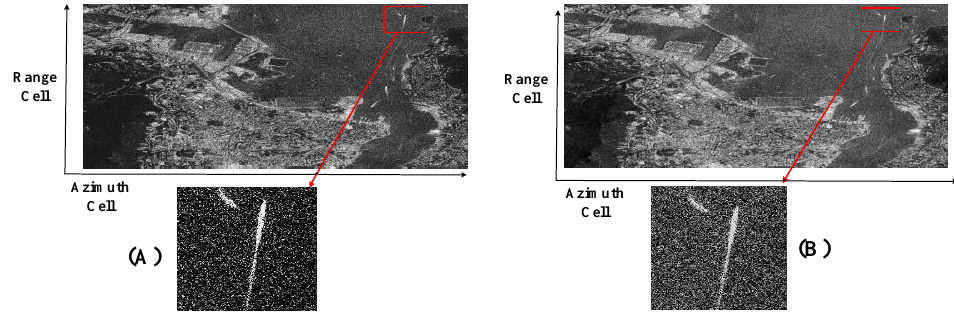
Figure 16. A 0.3 m resolution sliding spotlight image. ( A ) Using the proposed weighting method; ( B ) Using the azimuth weighting method in the range time domain. The extension of the area is of about 1 km × 1 km.